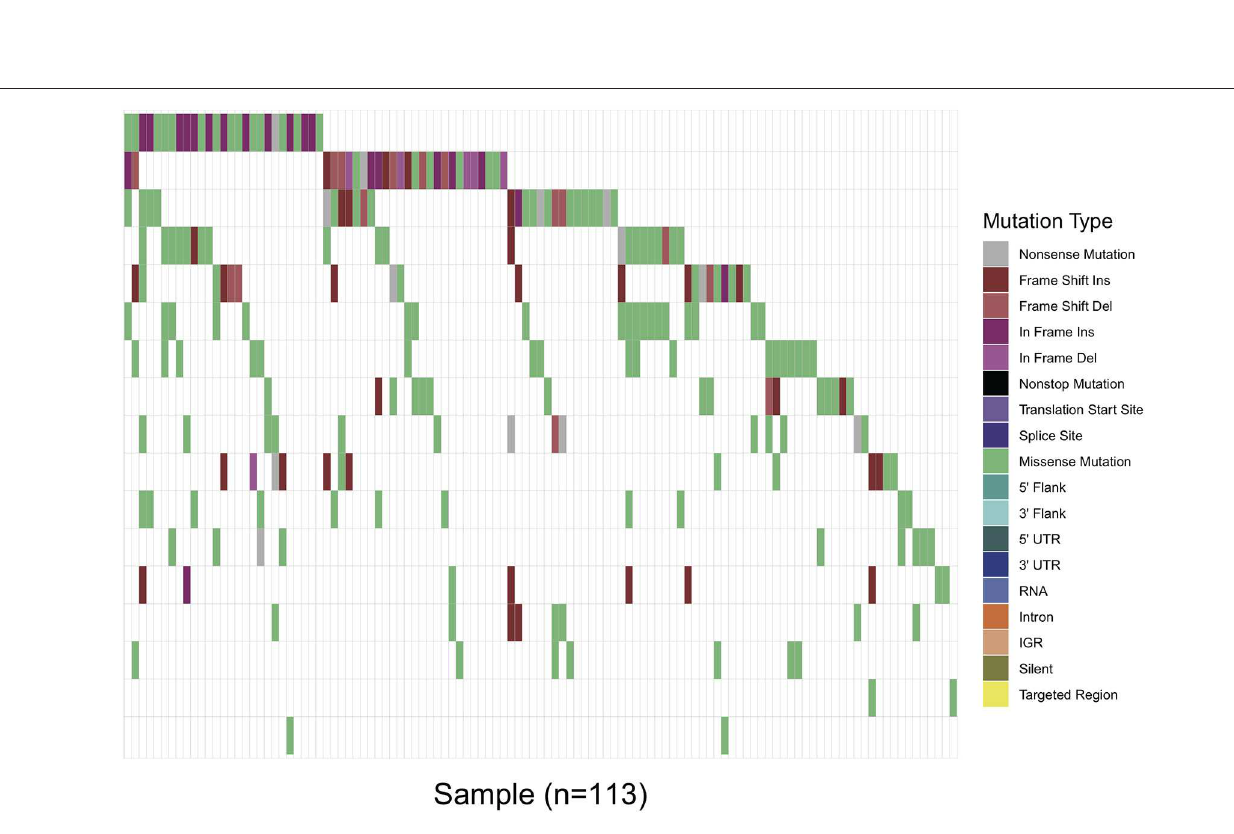
Frontiers in Oncology |